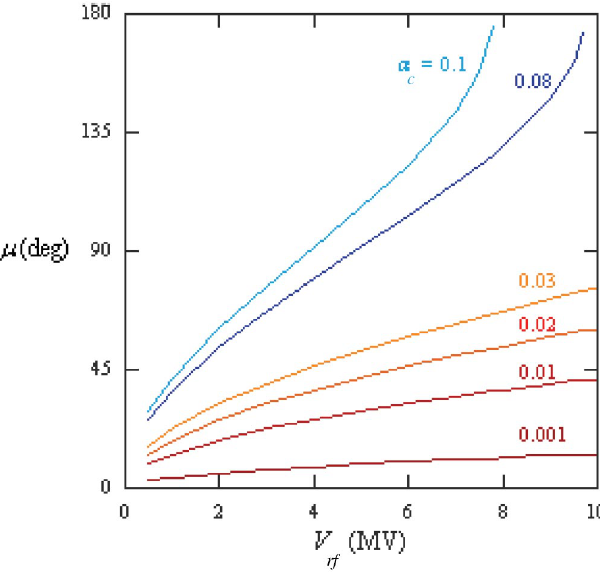
FIG. 2. (Color) Longitudinal phase advance as a function of the rf voltage at 1 : 3 GHz , E (cid:6) 510 MeV for different values of (cid:1)